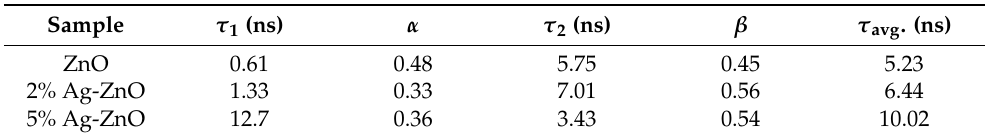
Table 1. The TRPL fitting parameters and the average lifetime of the pure ZnO, 2% Ag-ZnO, and 5% Ag-ZnO samples.